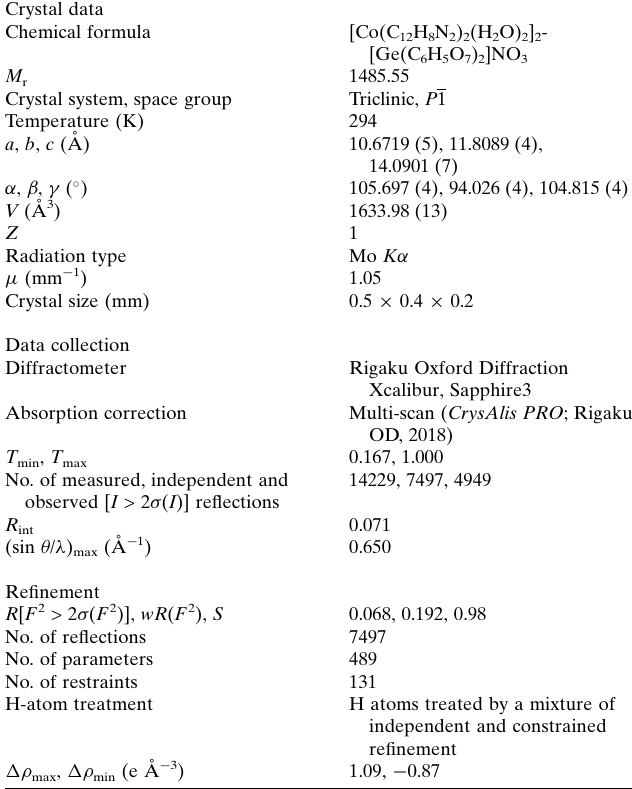
Table 3 Experimental details. Crystal data Chemical